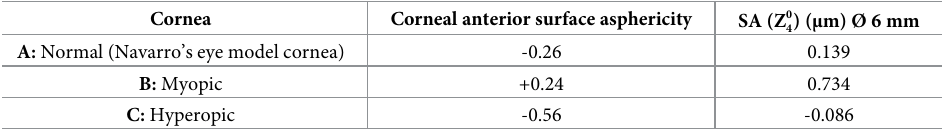
Table 2. Corneal asphericity used to simulate corneas after myopic and hyperopic laser ablation surgery [20]